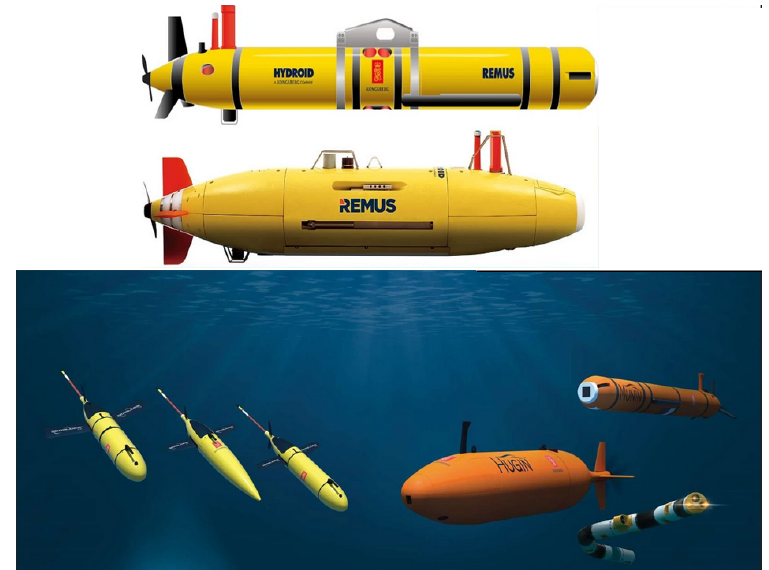
Figure 1. Illustrative examples of AUV